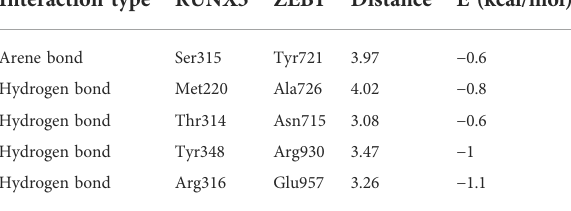
TABLE 3 The docking results of RUNX3 and ZEB1. Interaction type RUNX3 ZEB1